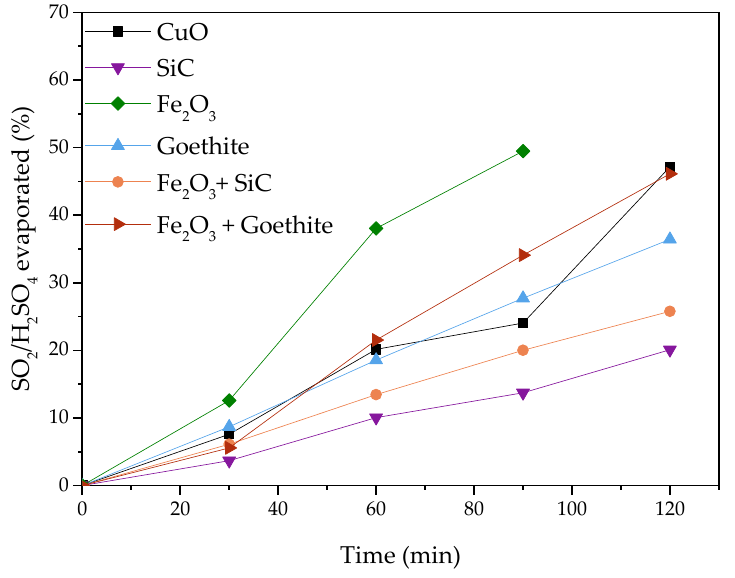
Figure 4. Time course of H 2 SO 4 conversion to SO 2 by different catalysts (catalyst amount: 1 g; 1173 K).